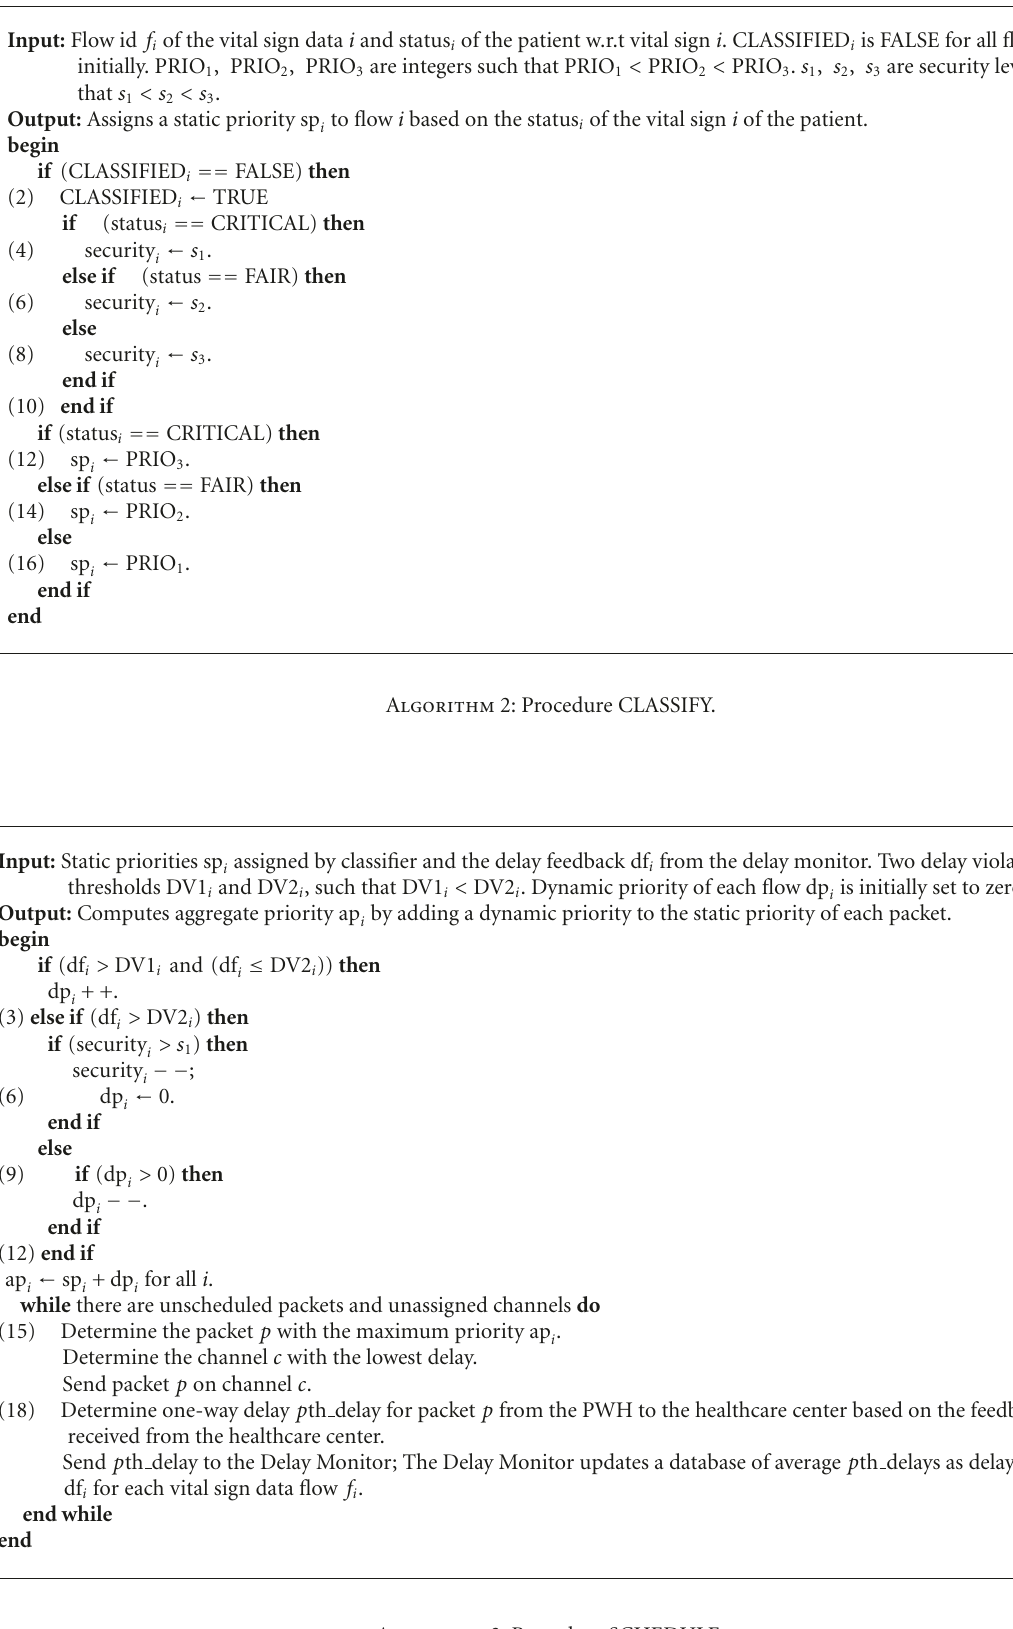
Algorithm 3: Procedure